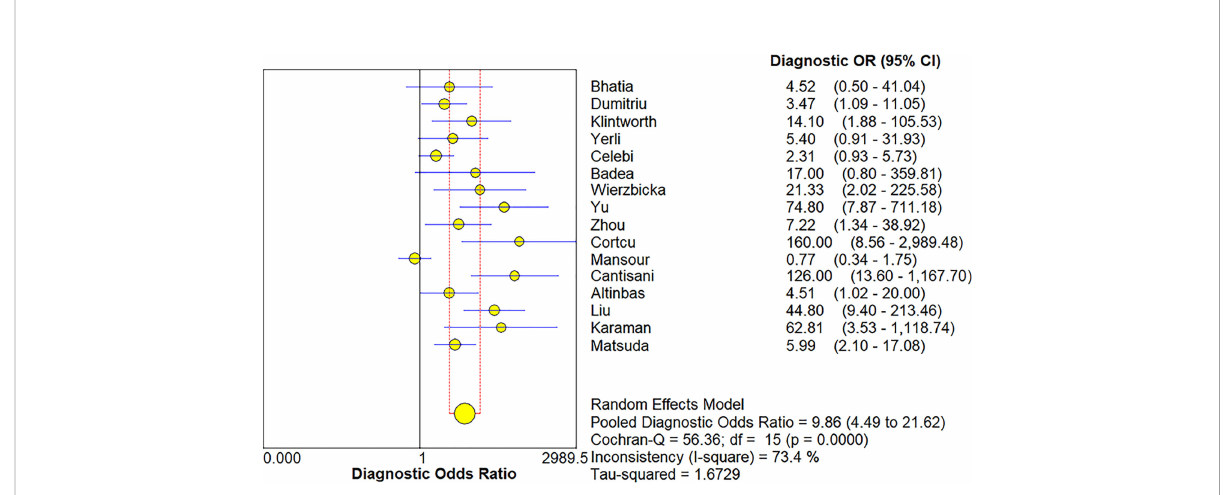
FIGURE 4 Forest plot for diagnostic odds ratio of elastosonography for diagnosis of malignant salivary gland